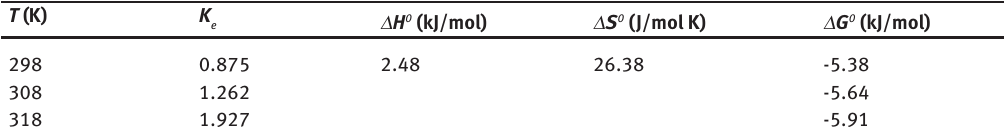
Table 3: Thermodynamic parameters for the extraction of vanillic acid from pumpkin